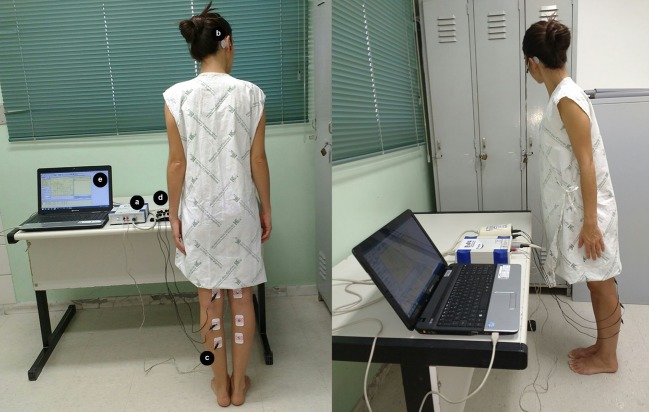
Vestibular-evoked myogenic potential triggered by galvanic vestibular stimulation procedure.The standing position of the patient (barefoot on a hard flat surface with eyes closed, feet close together and body leaning forward in order to cause the gastrocnemius muscle contraction); the equipment used for stimulus generation (a); the electrode positions for GVS (b); the electrode position for electromyography on the gastrocnemius muscle (c); the equipment for signal processing (d); and the laptop (e) connected to (a) and (d).